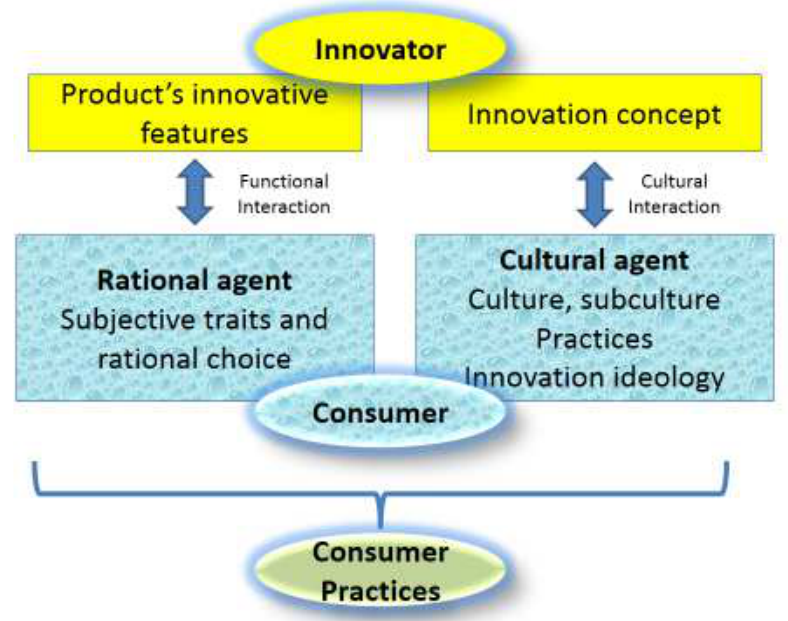
Fig. 1. Innovators view consumers as rational and cultural agents, resulting in consumer